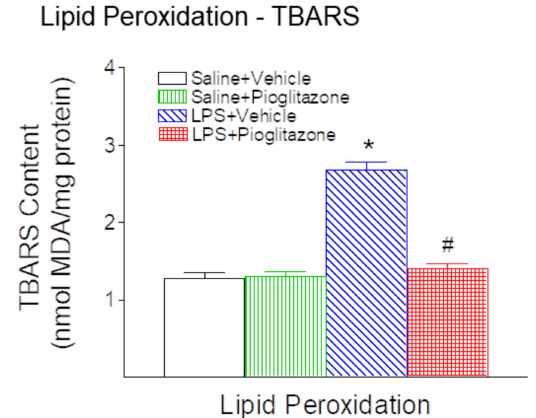
Figure 7. Pioglitazone reduced neonatal LPS exposure-induced increases in thiobarbituric acid- reactive substances (TBARS) content in the rat brain 24 h (P6) after LPS injection. Following LPS injection, the TBARS content in the brain was elevated compared with the control group in the P6 rat. Pioglitazone reduced LPS-induced increases in the TBARS content in the P6 rat brain. The results are expressed as the mean ± SEM (malondialdehyde, MDA equivalents) of eight animals in each group and analyzed by two-way ANOVA, followed by the Student-Newman-Keuls test. * p < 0.05 represents a significant difference for the LPS + Vehicle group as compared with the Saline + Vehicle group. # p < 0.05 represents a significant difference for the LPS + Pioglitazone group as compared with the LPS + Vehicle